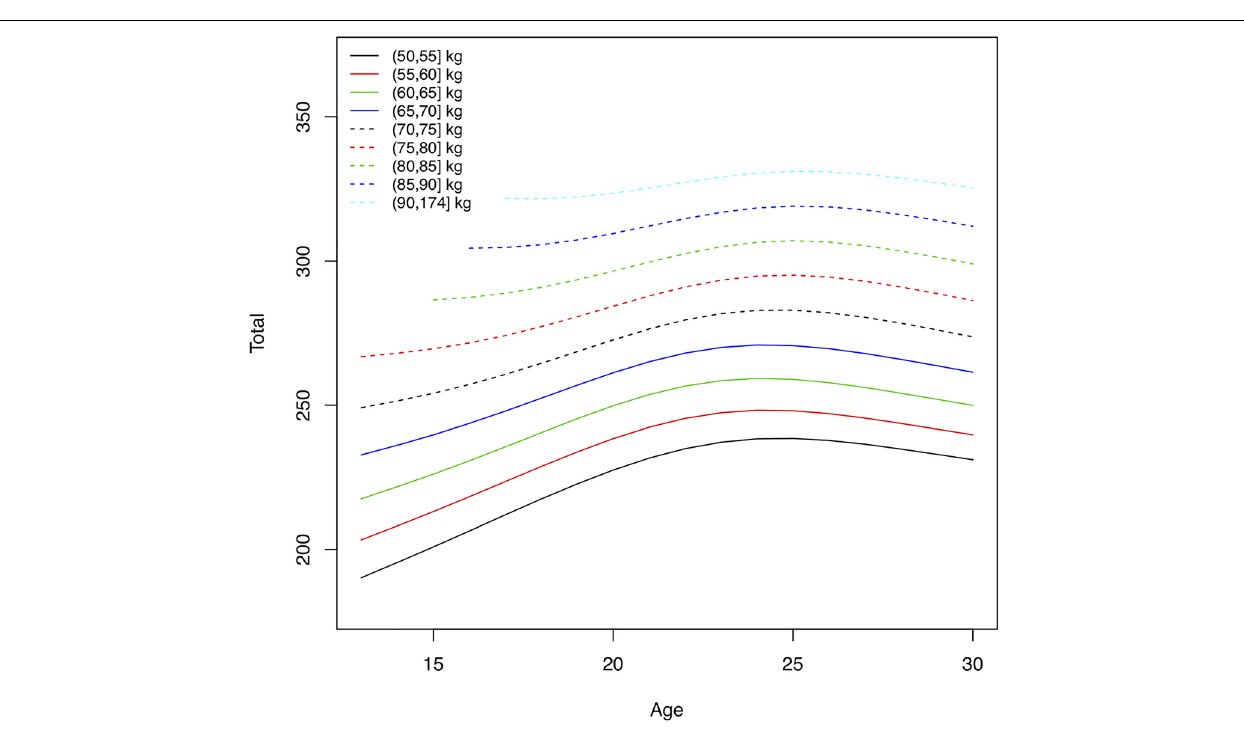
Frontiers in Physiology |